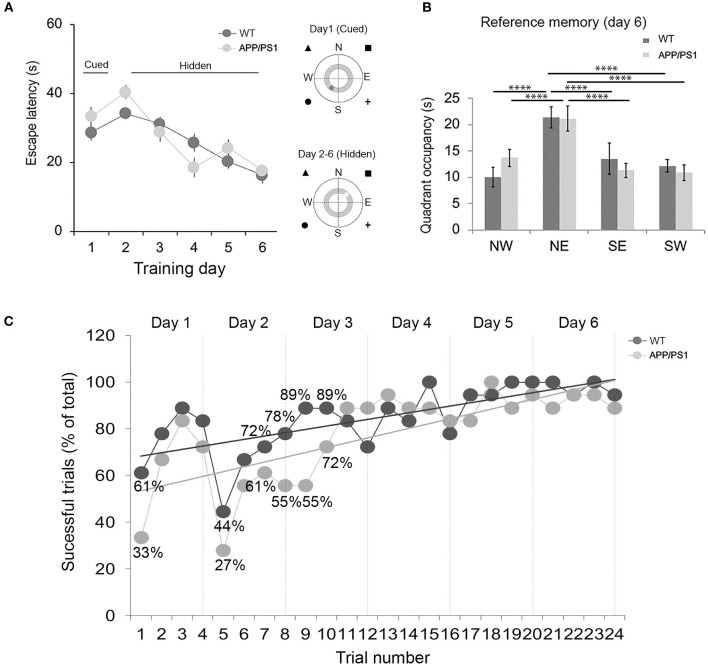
Evaluation of spatial learning in APP/PS1 mice using the Morris water maze [(A), to the right] Illustration depicting the water maze pool virtually divided into four equal quadrants (NE, NW, SE, and SW) with four starting positions (N, S, E, and W), along with the extra maze cues. The inner gray circle represents the annulus zone. [(A), to the left] Performance was evaluated as average escape latency between 2-month-old wild-type (WT; dark circle) and APP/PS1 (light circle) mice. (B) Reference memory was evaluated 2 h after the final trial on day 6. (C) Performance was evaluated as the percentage of successful trials between 2-month old WT and APP/PS1 mice during learning acquisition from days 1 to 6. Greater than 10% differences in successful trials across days 1, 2, and 3 between WT and APP/PS1 are highlighted with corresponding numbers. The trendline depicts the percentage difference across successful trials across WT (dark gray) and APP/PS1 (light gray). Data are presented as mean ± SEM; n = 18. ****P < 0.0001.